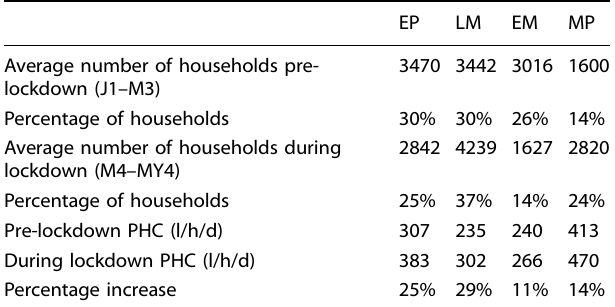
Table 1. Comparison between pre-lockdown and lockdown impact on household clusters ’ water